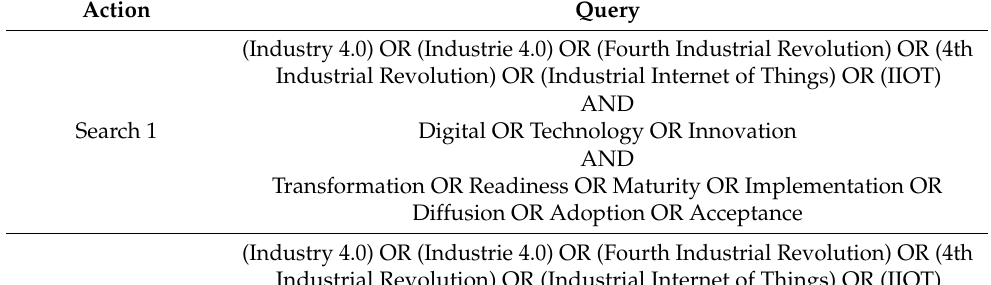
Table 2. Search parameters used to query SCOPUS and Web of